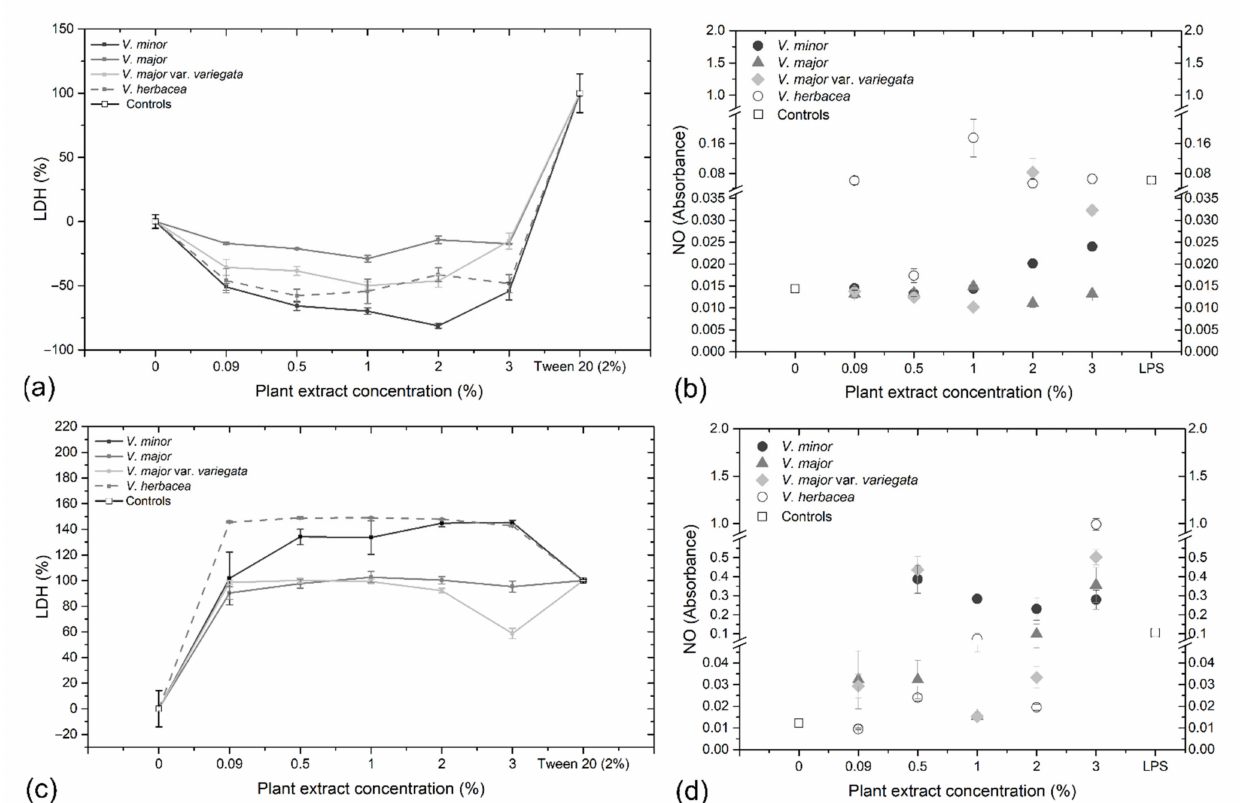
Figure 7. In vitro analysis of LDH ( a ) and NO ( b ) release in normal keratinocytes (HaCaT) treated with the plant extracts for 48 h and in vitro analysis of LDH ( c ) and NO ( d ) release in skin melanoma cells (A375) treated with the Vinca leaf extracts for 72 h; LPS =